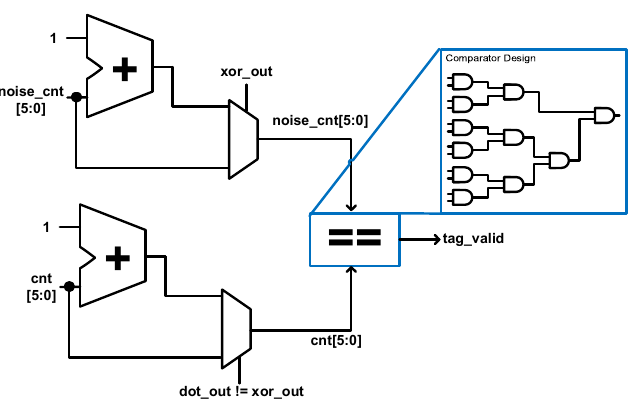
Figure 9. Proposed unified authentication unit.